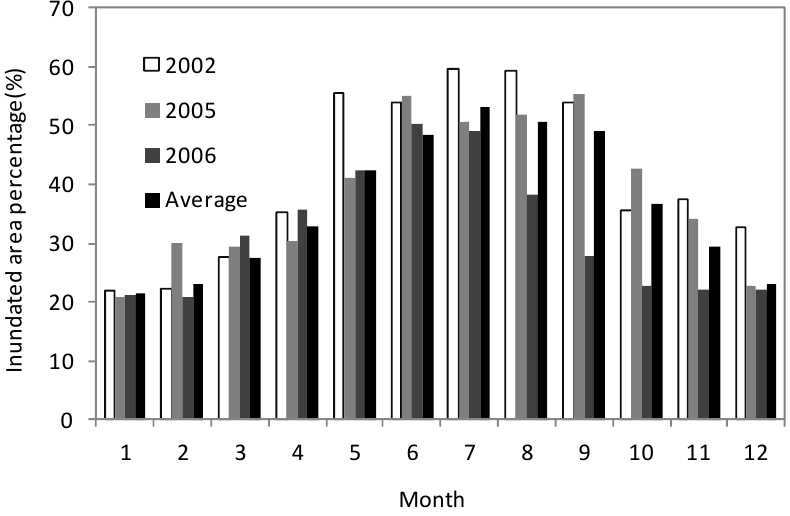
Figure 3. Seasonal variation in the inundated area of the Poyang Lake wetland in 2002, 2005, and 2006.